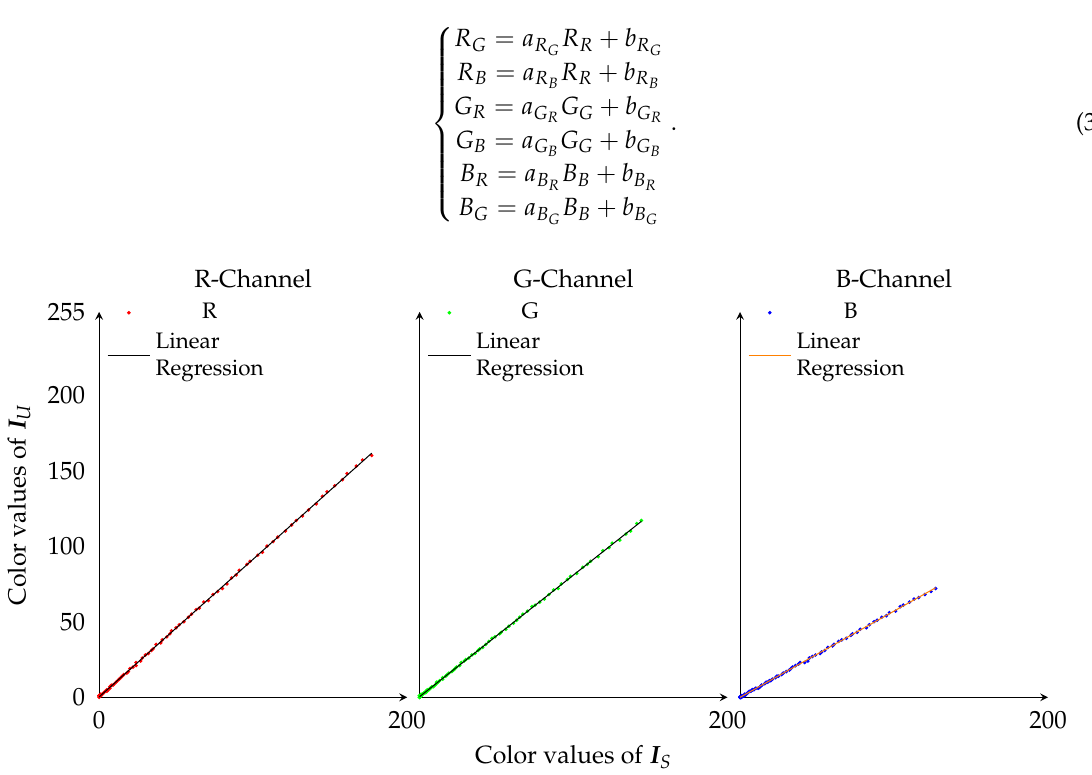
Figure 8. Observed color data plot for the decay of light through the